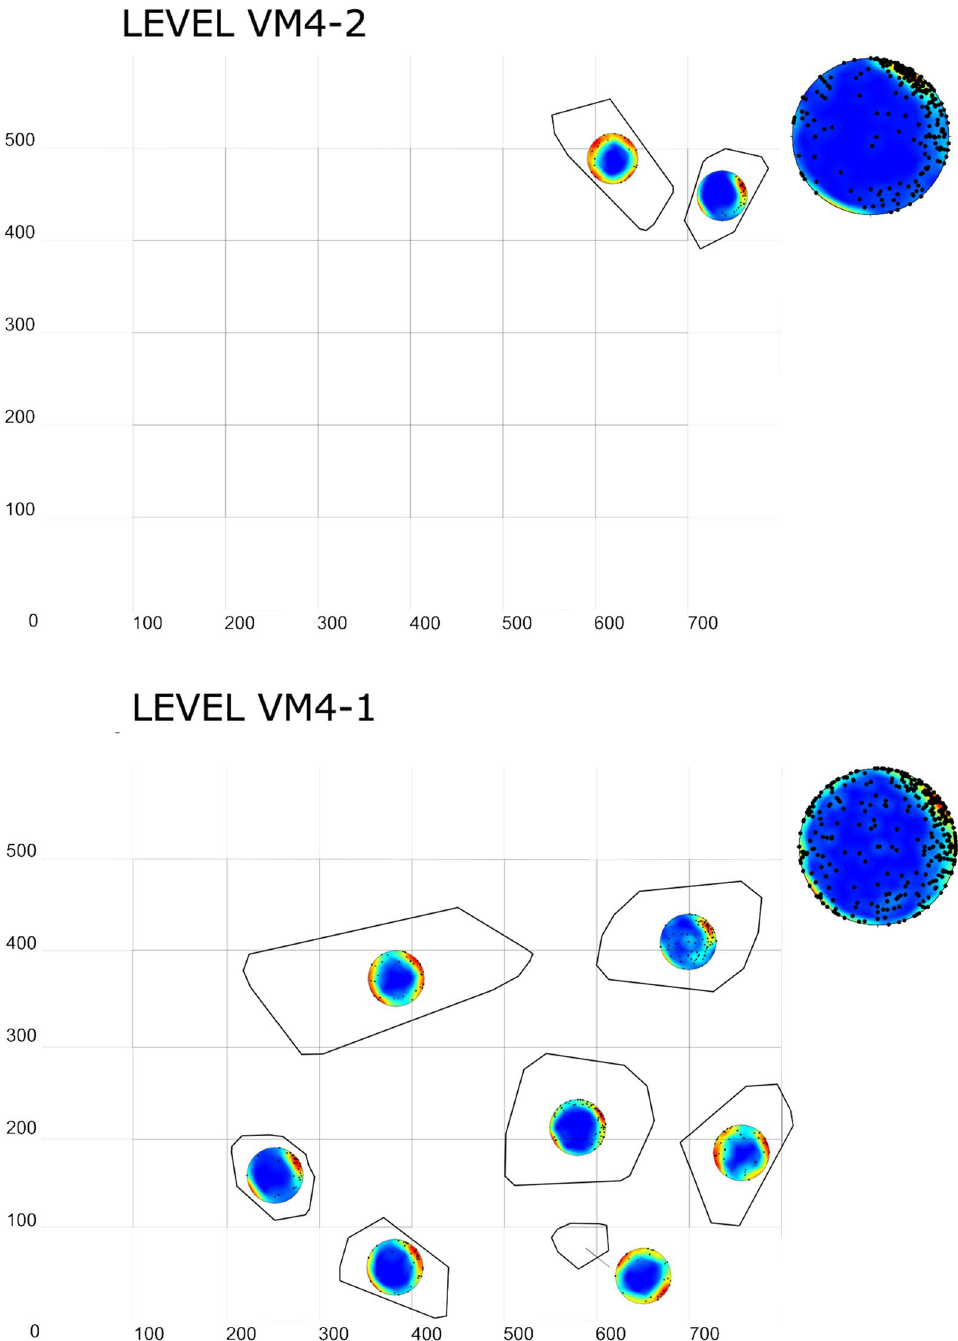
Figure 5. Spatial distribution of fossils recovered from both VM4-I ( A , B ) and VM4-II ( C , D ). ( A , C ) Raw spatial coordinates of fossil finds. ( B , D ) Clusters calculated using Density Based pattern recognition